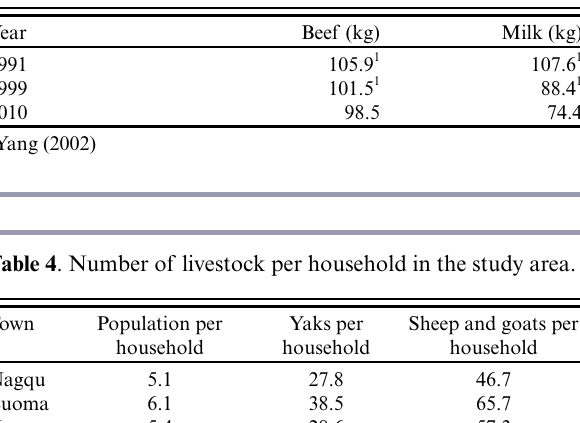
Table 3 . Comparison of yak productivity in 1991, 1999, and 2010 in the study area.